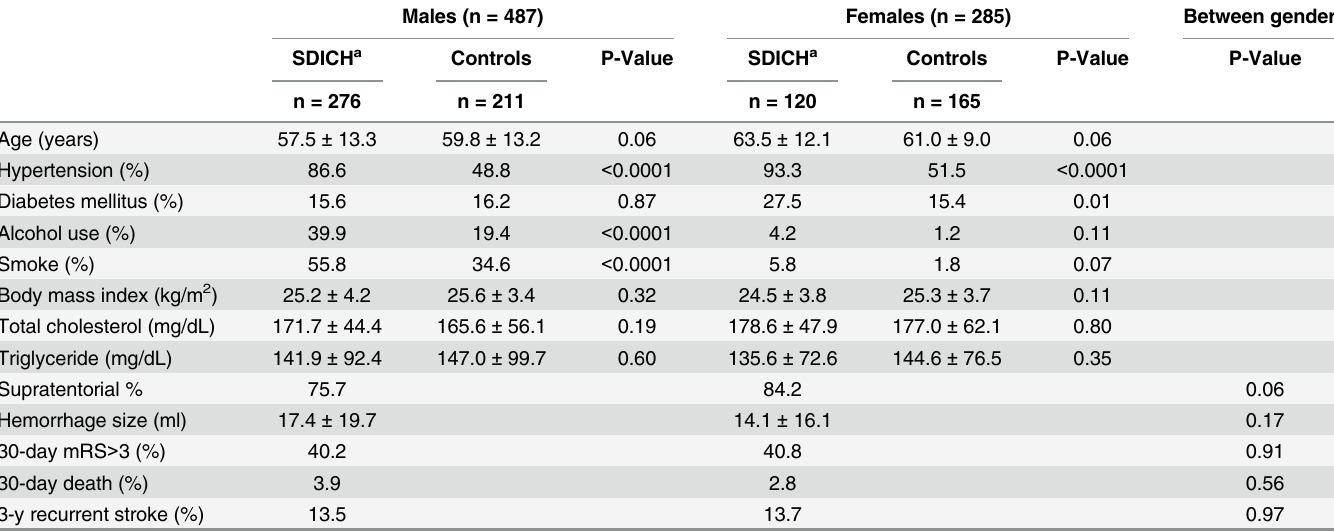
Table 1. Demographic data in patients with spontaneous deep intracerebral hemorrhage and